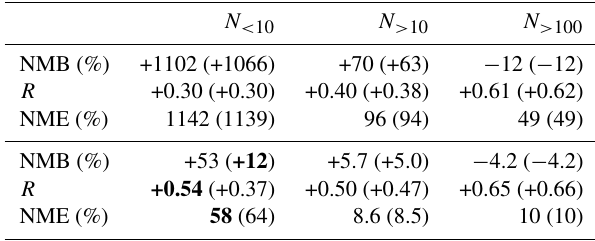
Table 2. Normalized mean bias (NMB), correlation coefficient ( R ), and normalized mean error (NME) of the simulated particle number concentrations compared to the observed ones. The values in paren- theses denote the values with the original emission inventory. The top values are calculated from the ordinary concentrations and the bottom values from the logarithms of the concentrations. The bold values highlight the most notable differences between the invento- ries (the best-performing in